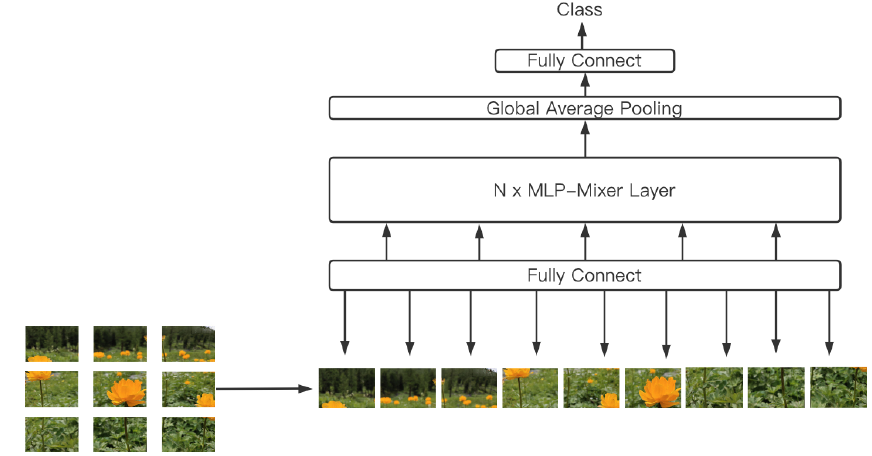
Figure 4. MLP-Mixer Flow Chart.